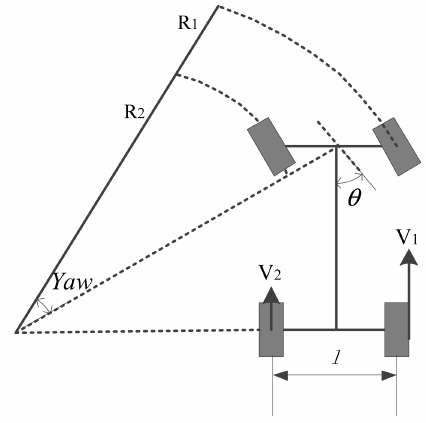
Figure 6. Actual yaw rate